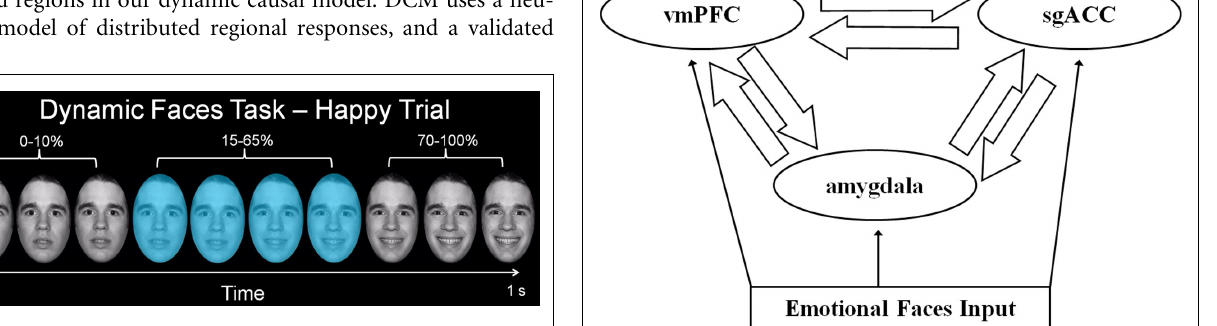
FIGURE 2 |The trinodal model including subgenual anterior cingulate cortex (sgACC), ventromedial prefrontal cortex (vmPFC), and amygdala and bidirectional connections among regions. Facial stimuli entered the model at each